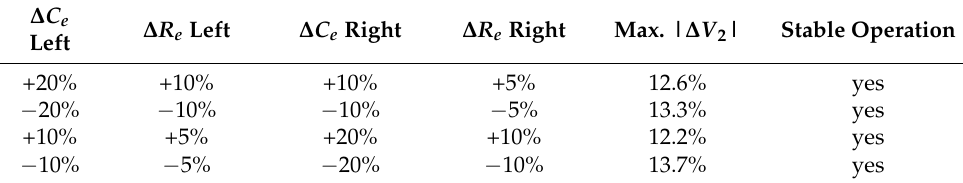
Table 13. Results of robustness analysis against variations of C e and R e in Scenario